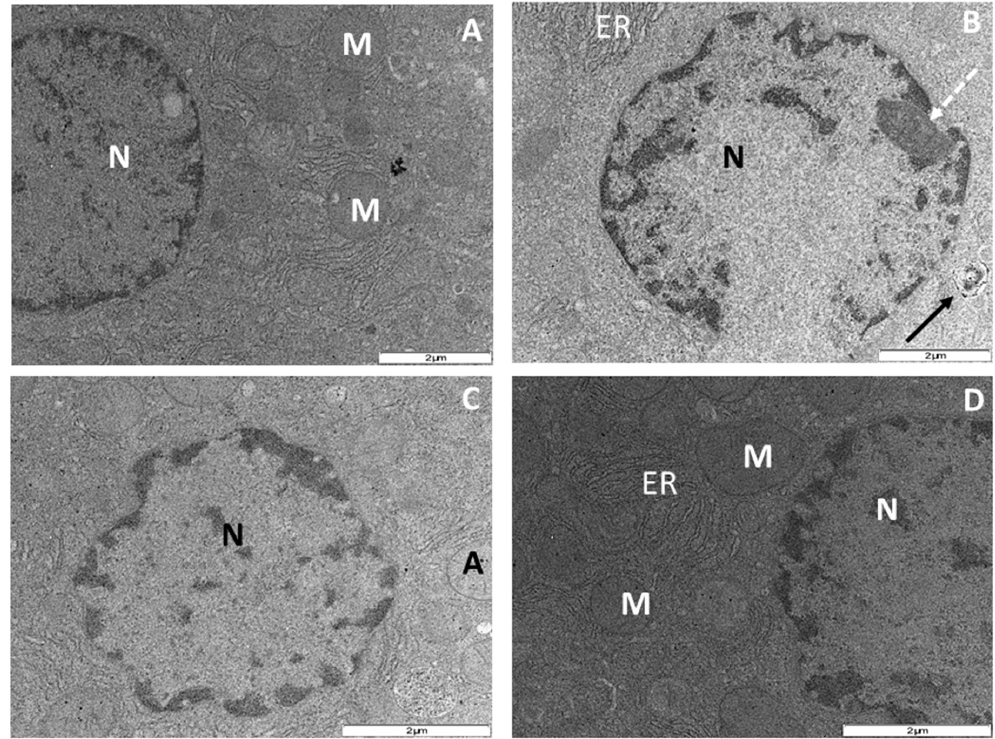
Figure 7. Transmission electron micrograph of rat hepatocytes after 56 days of drug treatment. M = mitochondrion, ER = endoplasmic reticulum and N = nucleus. ( A ) Control rats showing normal nucleus with an even distribution of the nuclear chromatin granules, evenly distributed cytoplasm and preserved mitochondrial architecture; ( B ) AZT ‐ treated rats with markedly reduced mitochondrial population, prominent nucleolus (broken black arrow), clumped and fragmented nuclear chromatin granules coupled with a discontinuation of the nuclear envelope and an apoptotic body (thick back arrow); ( C ) AZT+NAR ‐ treated rats showing minimal clumping of the nuclear chromatin granules, intact nuclear envelope and preserved mitochondrial architecture; ( D ) AZT+VITE ‐ treated rats with intact nuclear envelope, slight clumping of the nuclear chromatin granules in addition to preserved mitochondrial architecture. (Original magnification of reference scale markings: 2 μ m = × 15,000).